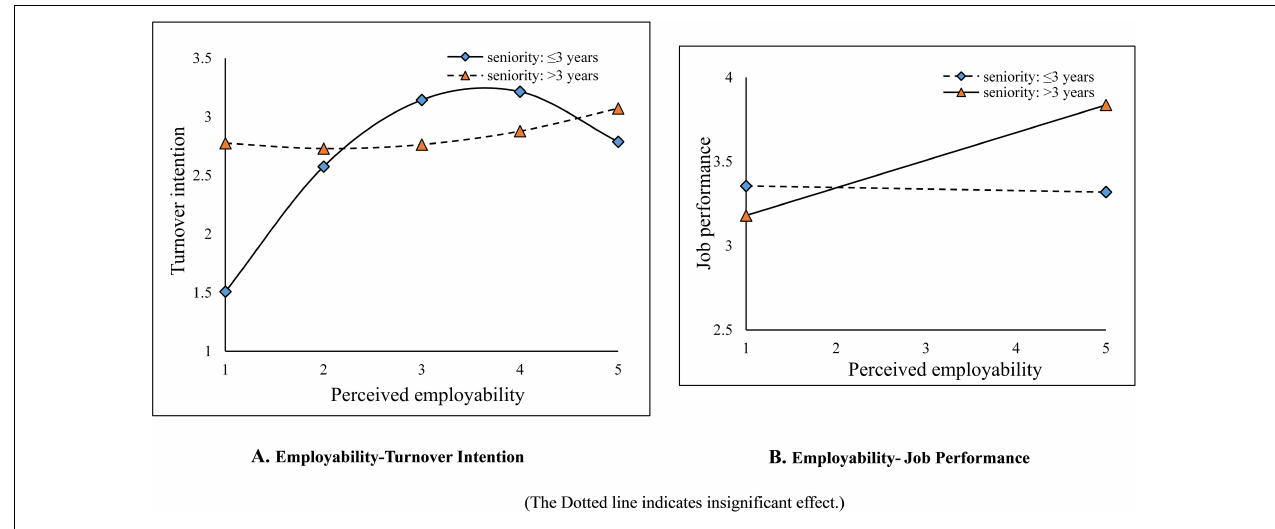
FIGURE 1 | Effects of work seniority on perceived employability-turnover intention, and perceived employability-job performance relationship.